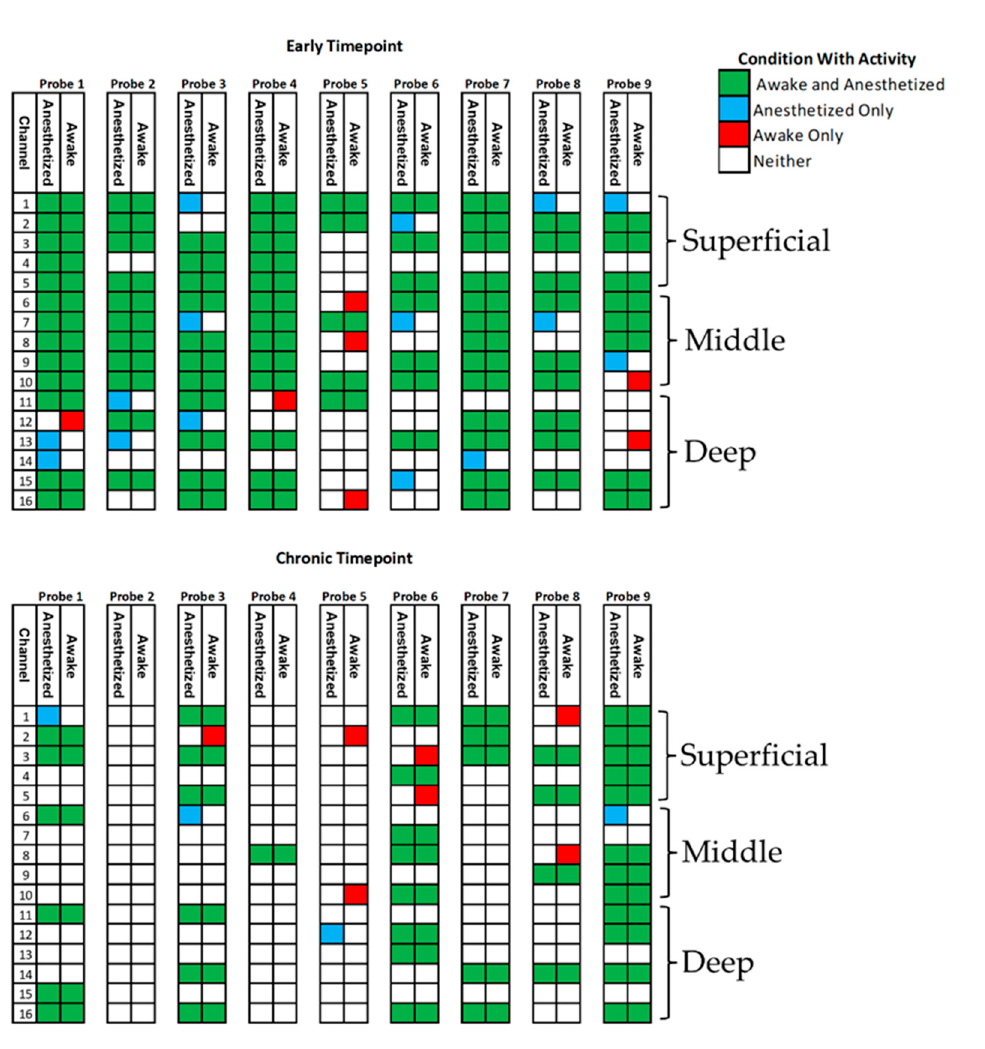
Figure 3. Effect of isoflurane anesthesia on AEY. Schematic depicting activity under anesthetized and awake conditions arranged by depth for early and chronic time points. The condition under which activity was observed is color-coded. Probe 2 was excluded from analysis at the chronic time point because units could not be reliably observed on the device by week